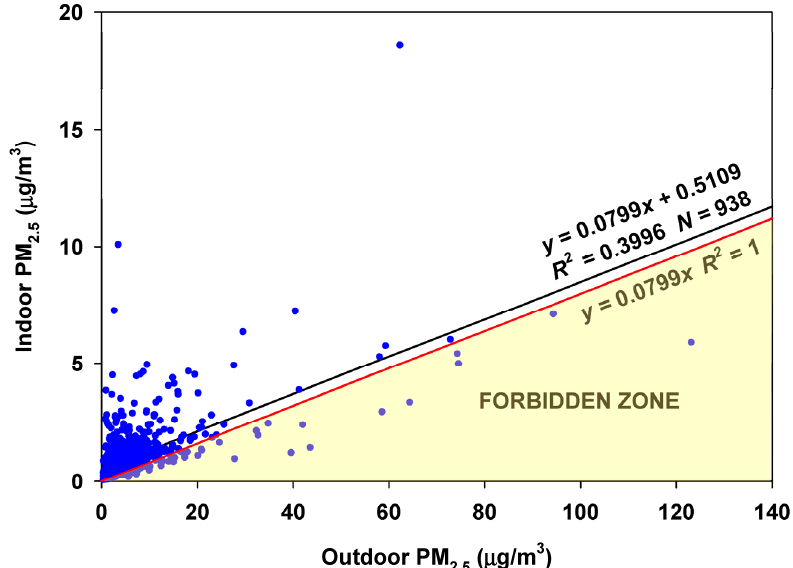
Figure 11. RCS regression for the period from 2020 to 2022.